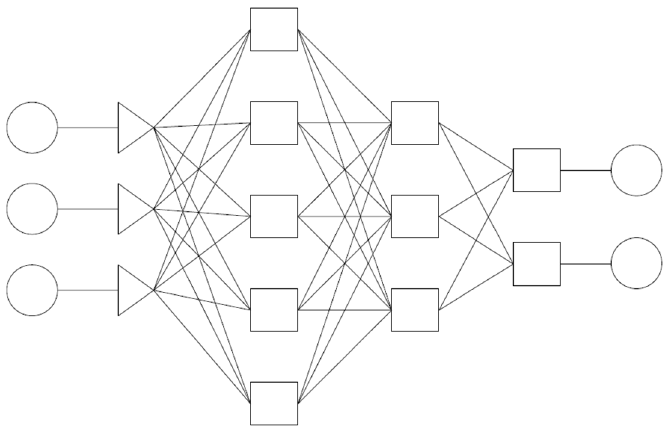
Figure 1. Diagram of an artificial neural network based on [51–53].